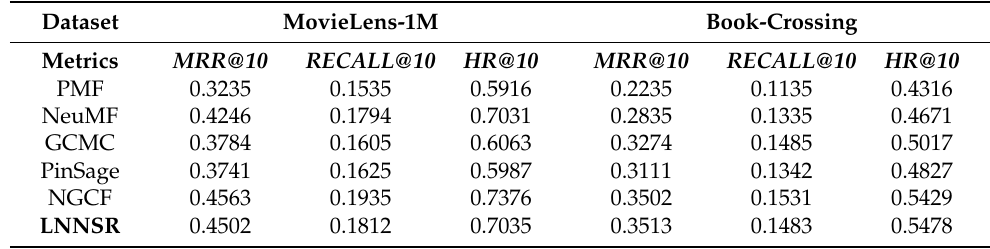
Table 3. Performance comparison of top-10